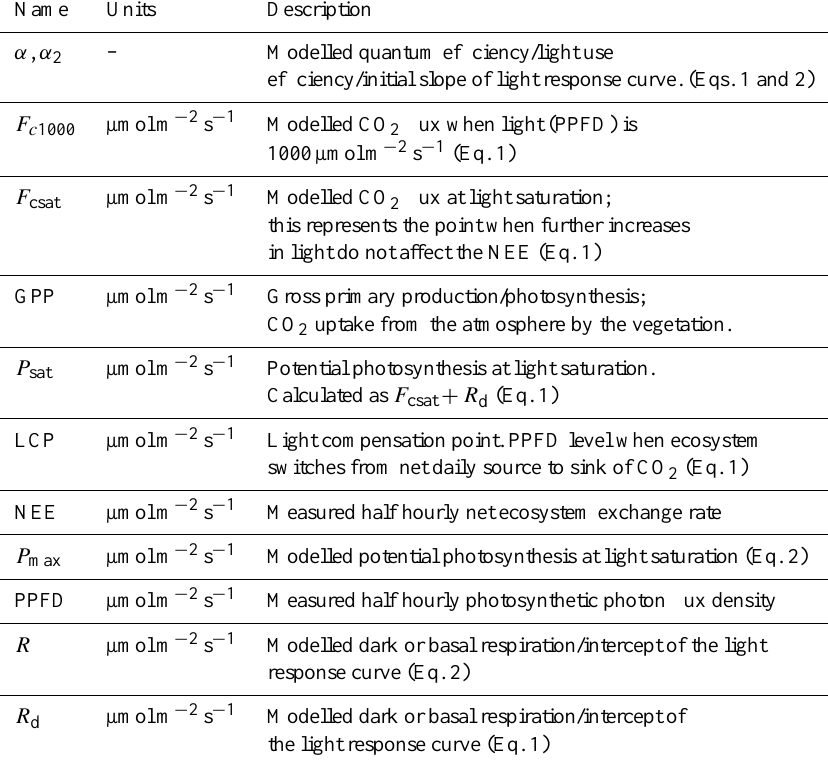
Table A1. List of symbols.